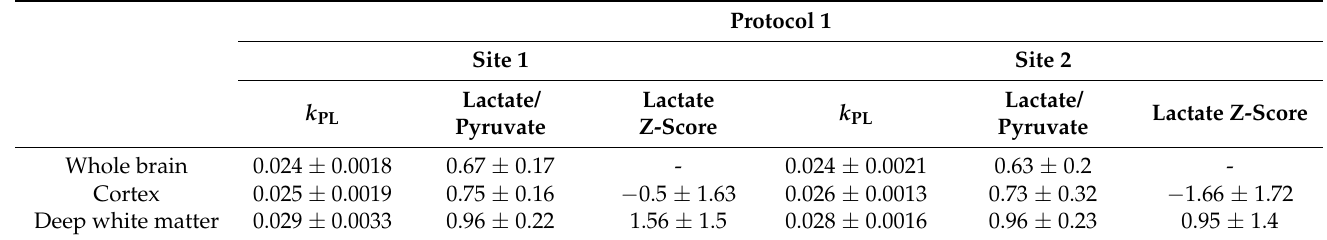
Table 2. Average metabolic metrics in regions of interest compared between the two sites ( n = 5 at site 1, n = 3 at site 2) using the same single-resolution protocol (Protocol 1).